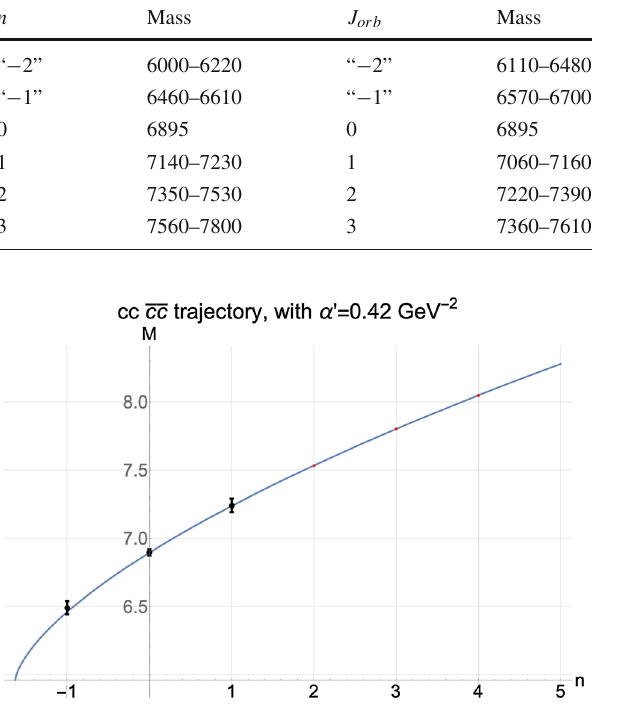
decay via tearing of the string, which is proportional to